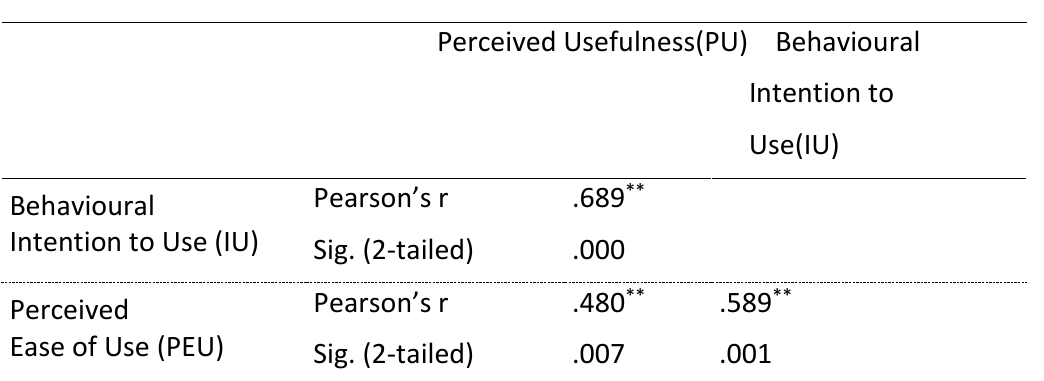
Table 7. Correlations among